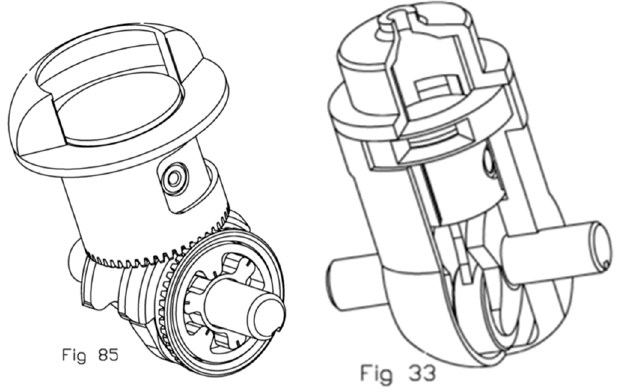
Figure 23. Pattakos December 2018 rotary sleeve valve for asymmetric timing in two strokes GB 2563685. Reproduced with permission from GB Patent Office Copyright Publisher, 2018.